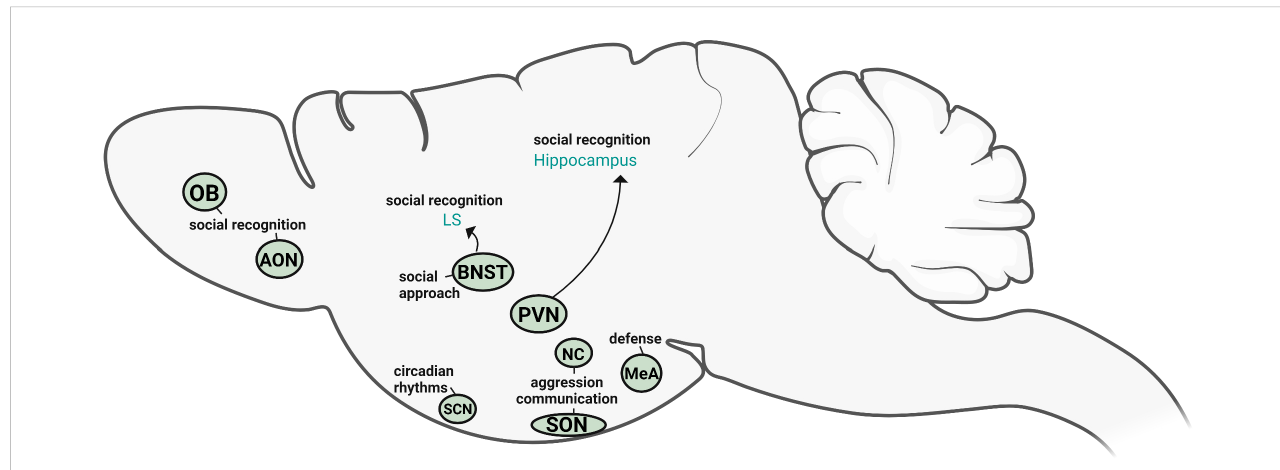
FIGURE 4 Sources of vasopressin relevant for social behavior . Based on the available direct evidence, the AVP cells within PVN, BNST, OB, and AON directly in fl uence social recognition and social approach, whereas NC and SON AVP cells modulate aggression and competitive signaling. MeA AVP cells primarily regulate defensive responses. SCN AVP cells regulate circadian rhythms but are not directly linked to social behavior. Created with